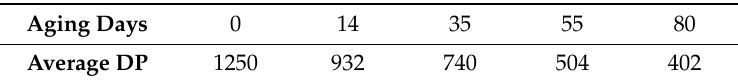
Table 1. Average DP of different aging days.